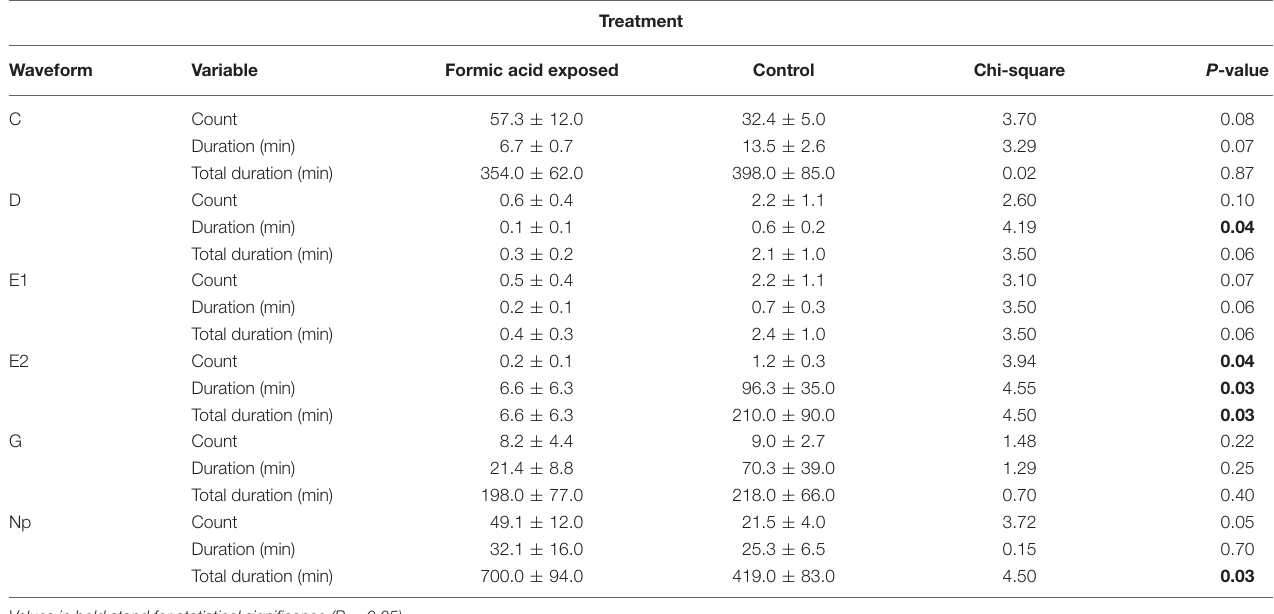
TABLE 1 | Frequency, mean duration and total duration of xylem and phloem feeding activities of Diaphorina citri adults on young C. macrophylla leaves, following formic acid exposure. Treatment Waveform Variable Formic acid exposed Control Chi-square P